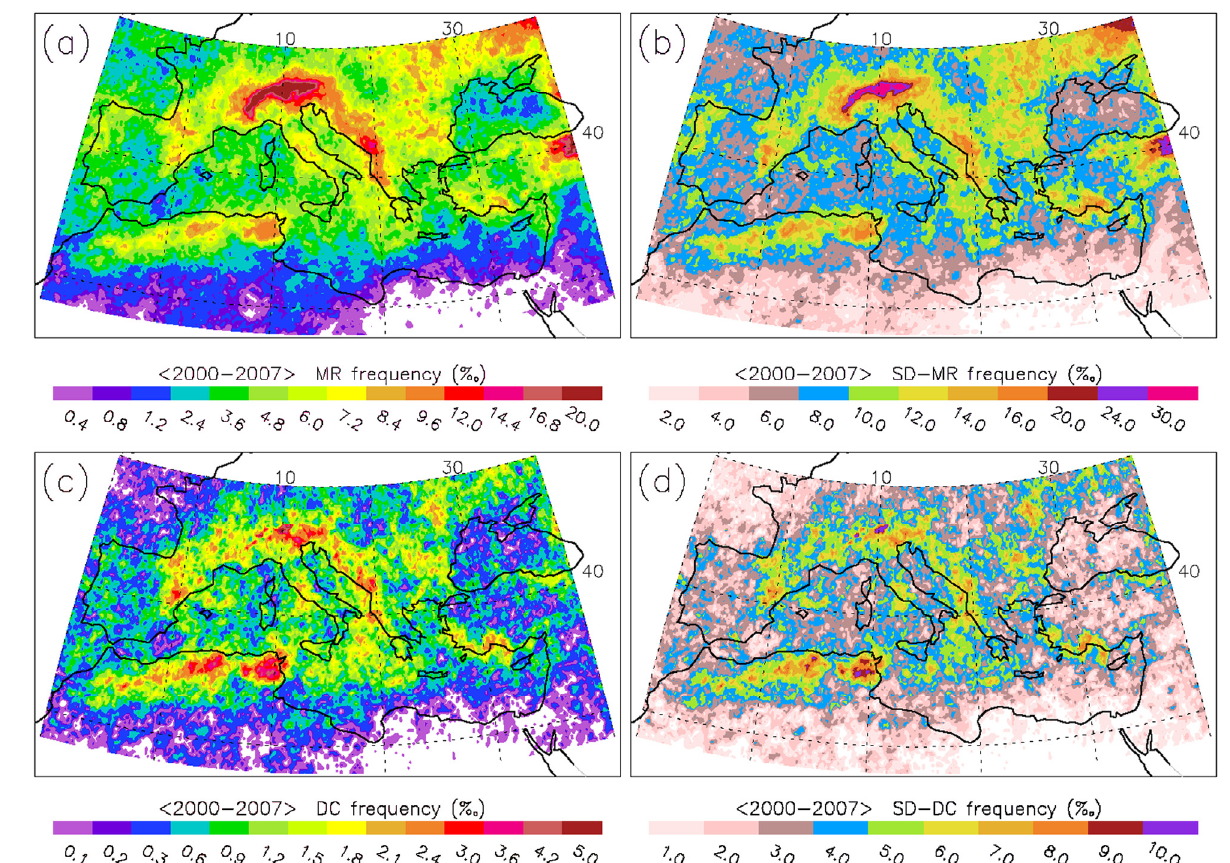
Figure 4. NOAA-15 climatologies: (left) mean state and (right) interannual variability computed as standard deviation of the monthly means over the period